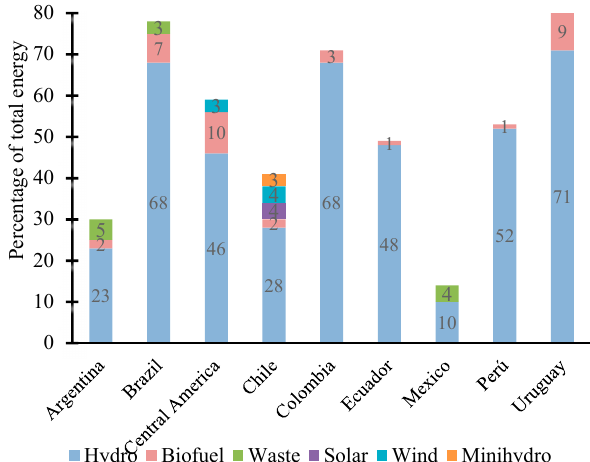
Figure 1. Energy generation by source type in Latin American countries [6].